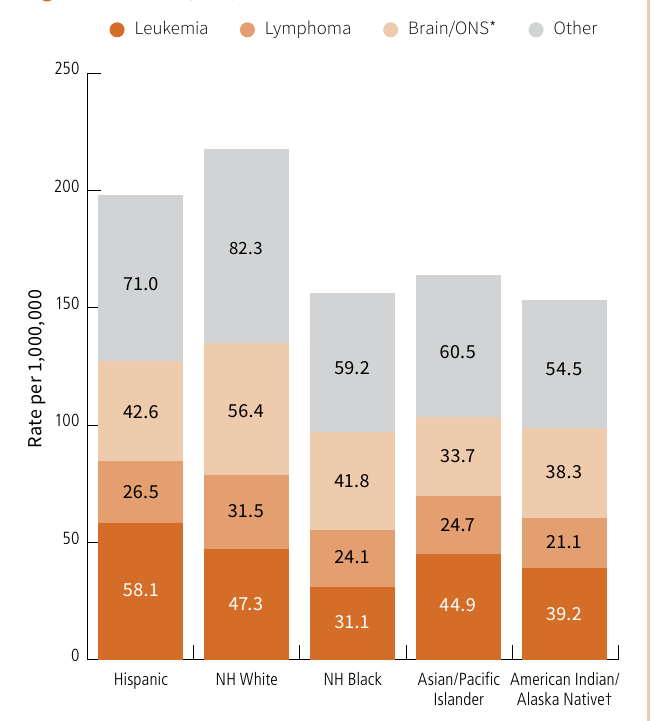
Figure 7. Comparison of Common Childhood and Adolescent Cancer Incidence Rates by Race/Ethnicity, Ages 0-19 Years, US,